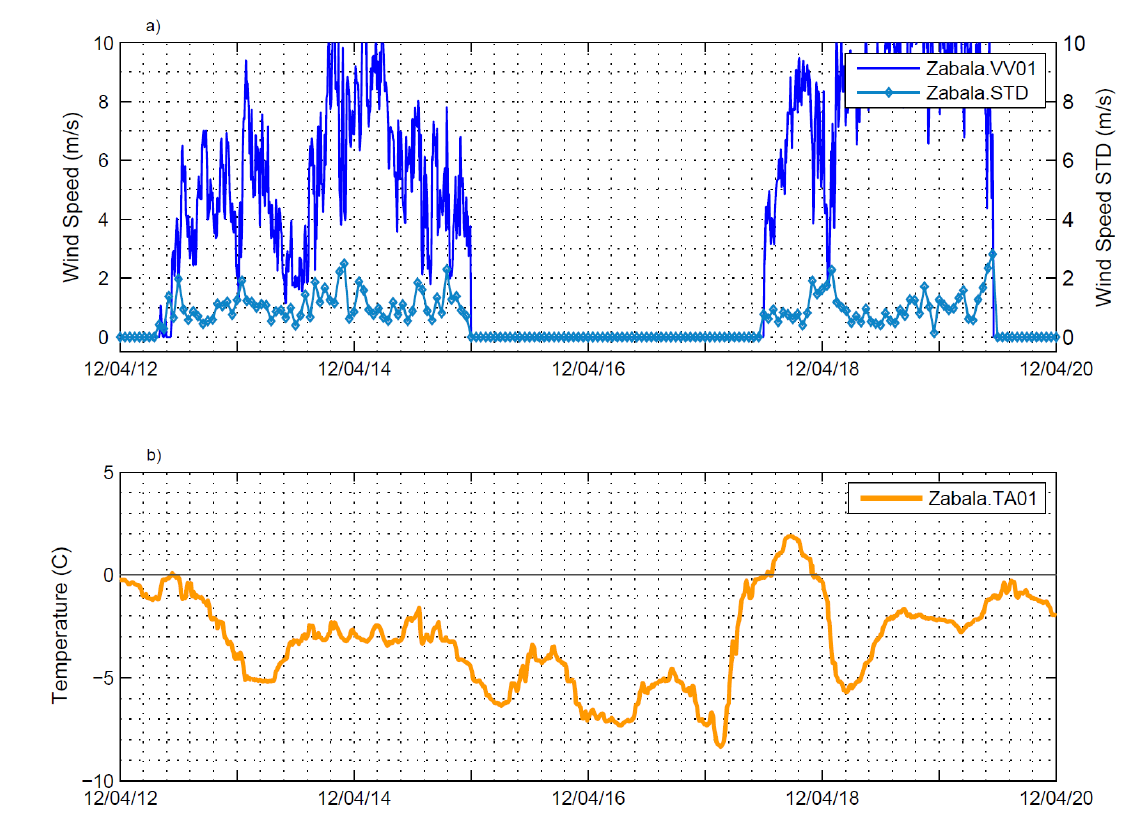
Figure 7. ( a ) Wind speed (Zabala.VV01) and standard deviation of wind speed (Zabala.STD) at Zabala site during a period affected by freezing rime; ( b ) Air temperature (Zabala.TA01) at Zabala during the same